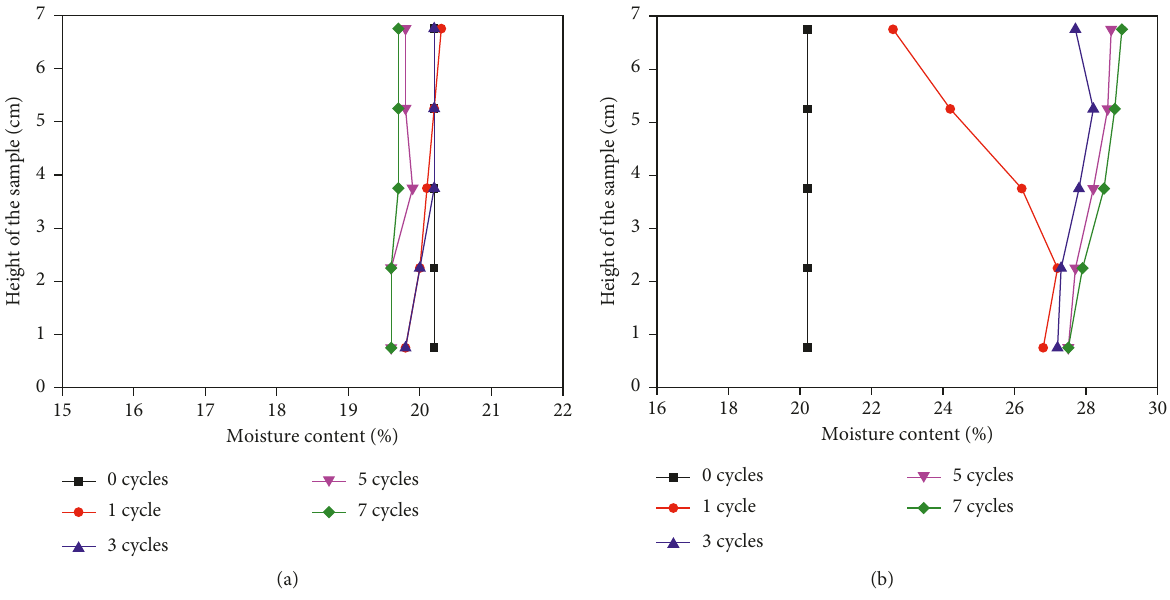
Figure 6: Moisture distribution by the height of the specimen after freeze-thaw cycles. (a) Closed system. (b) Open